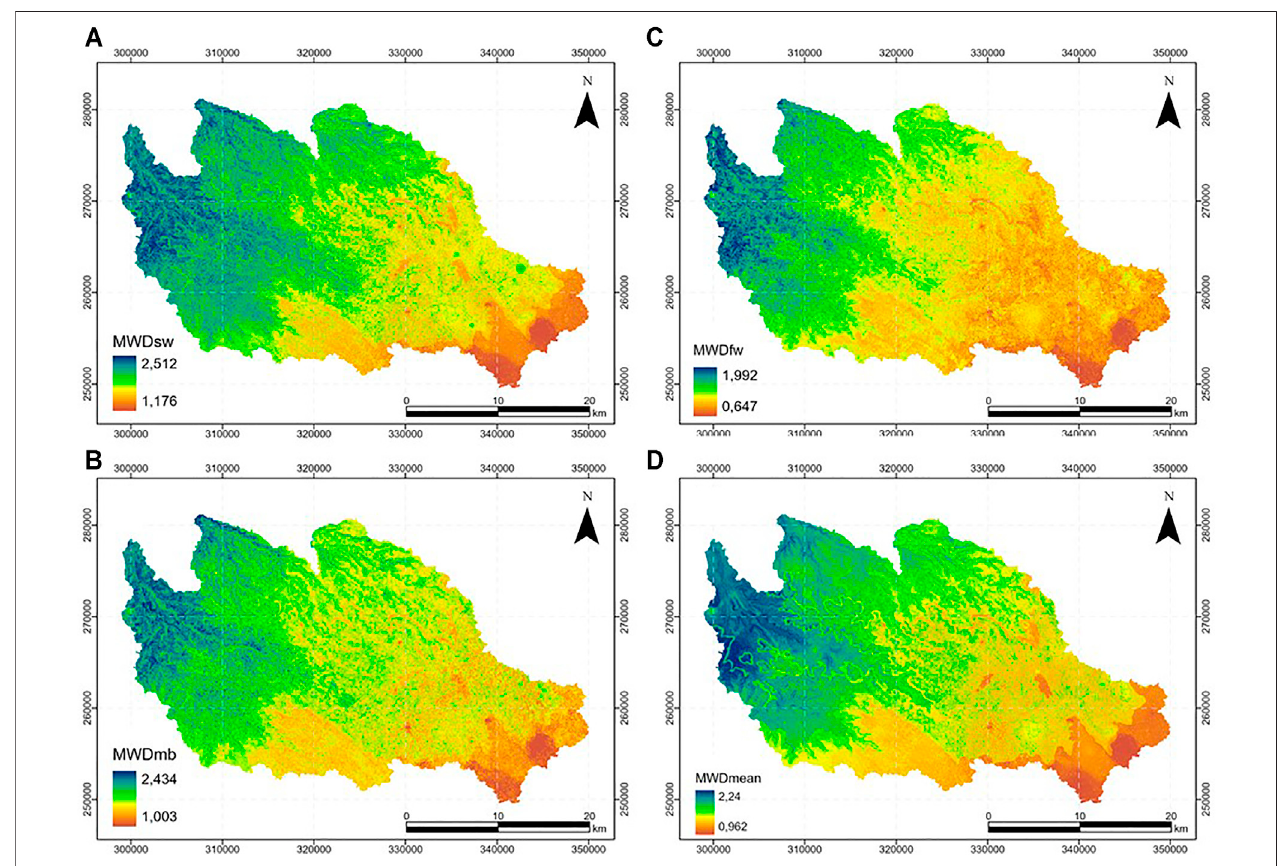
FIGURE 8 | Prediction maps of soil aggregate stability: (A) MWDsw, (B) MWDmb, (C) MWDfw and (D) MWDmean.